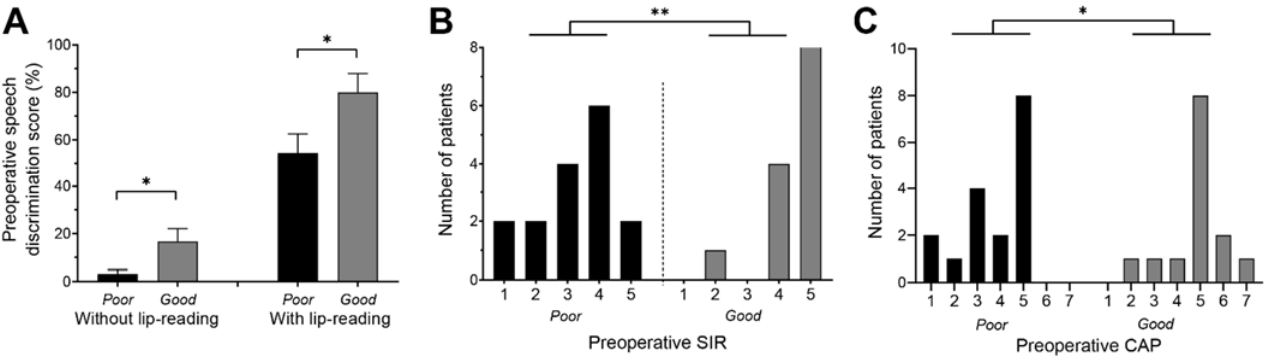
Figure 3. Preoperative assessments in the 2 groups. ( A ) Preoperative speech intelligibility for disyllabic words evaluated in optimal listening condition (i.e., with the 2 hearing aids if used) without and with lip-reading. Good performer group (GP) obtained better scores compared with to the poor performer group (PP) for the speech intelligibility without and with lip-reading (respectively p = 0.022, n = 15 for GP and 18 for PP, and p = 0.012, n = 13 for GP and 18 for PP, Mann–Whitney test). ( B ) Preoperative Speech Intelligibility Rating (SIR) scores. GP ( n = 15) had better scores compared with PP ( n = 16) ( p = 0.003, chi-squared test, 3 missing values in PP). ( C ) Preoperative Category of Auditory Performance (CAP) scores. GP ( n = 14) had better scores compared with PP ( n = 17) ( p = 0.032, chi-squared test, 1 missing for GP and 2 for PP). Data are mean ± SEM ( A ) and n ( B , C ). * p < .05; ** p < 0.005.